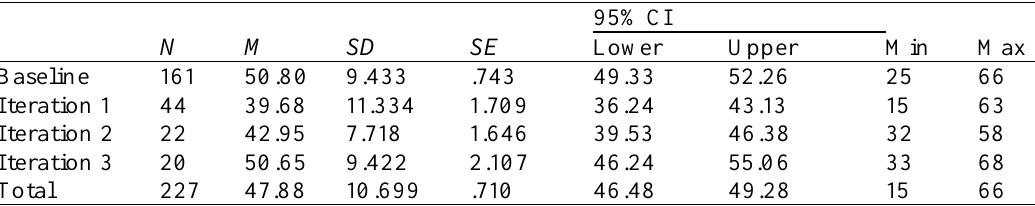
Descriptive Statistics for SOC in Each Iteration